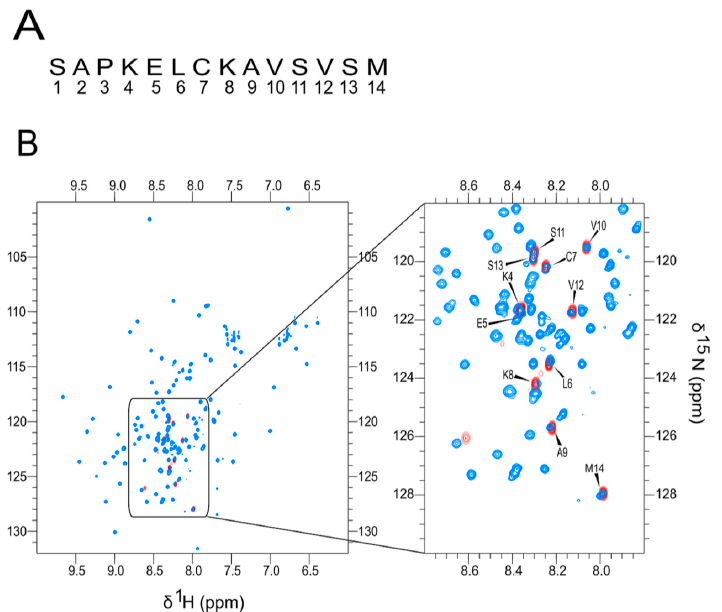
Figure 2. 1 H- 15 N Heteronuclear Single Quantum Correlation (HSQC) spectrum of KELCKAVSVSM ( A ) The peptide sequence. ( B ) An overlay of the amide region of the 1 H- 15 N HSQC spectrum of the HisSUMO–peptide fusion (blue) and the cleaved peptide (red) and to the left a blow-up of the relevant region of the HSQC